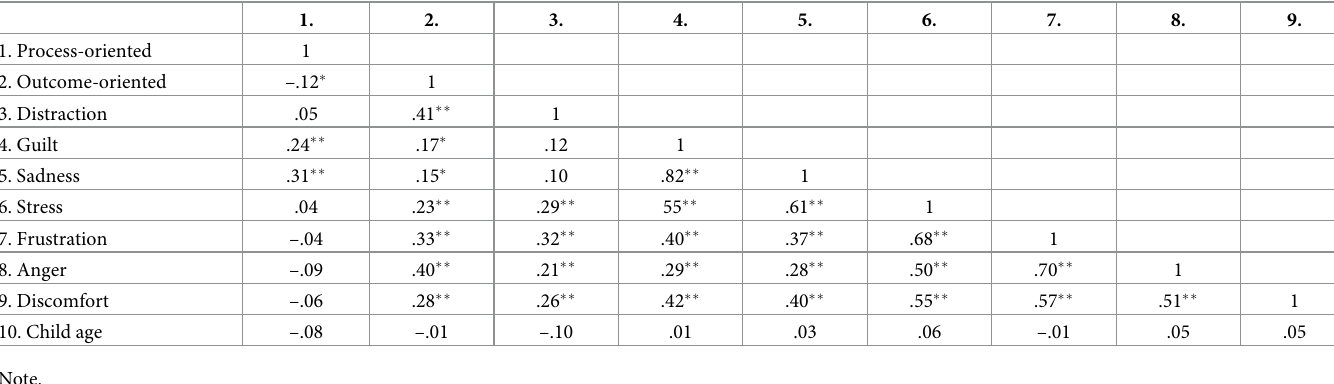
Table 2. Correlations among variables of interest for children’s perceived justified negative emotions.